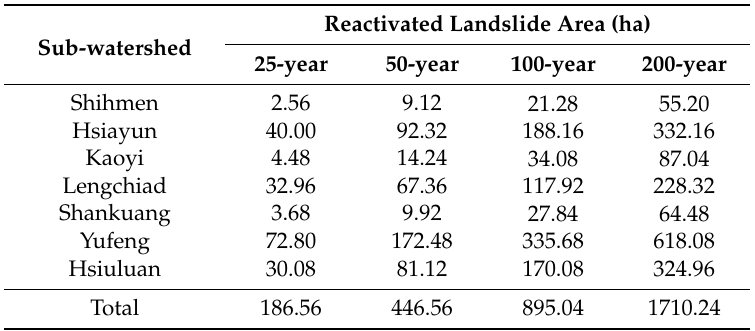
Table 4. Predicted reactivated landslide areas under different rainfall return